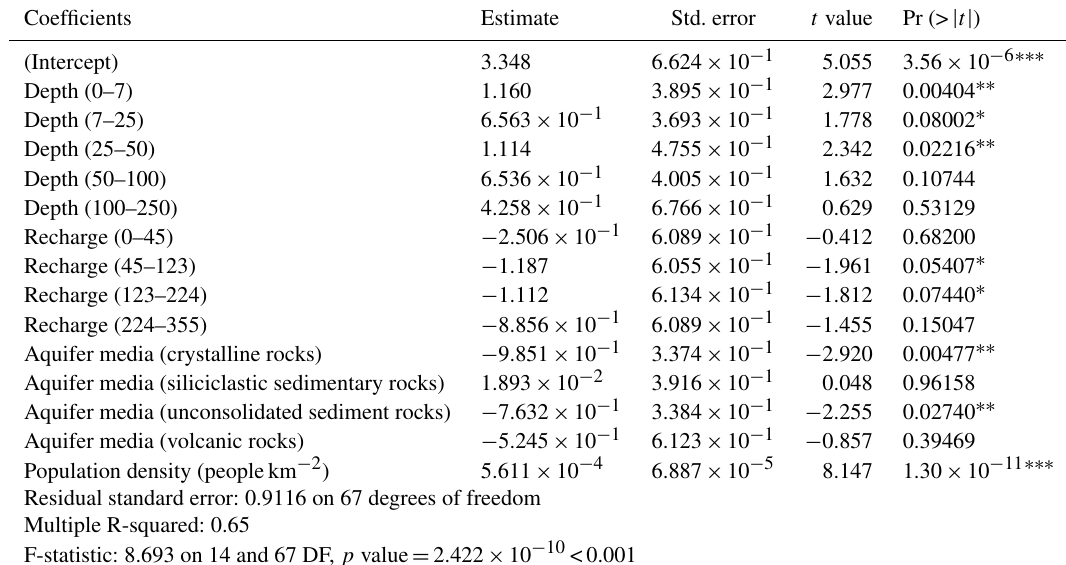
Table 5. Optimal linear regression model for explaining the log transformed mean nitrate concentration.